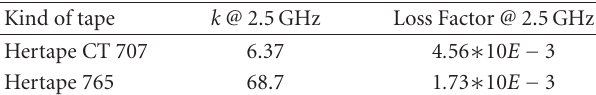
Figure 9: Cross-section of substrate layers using LTCC technology. Table 1: LTCC material properties.